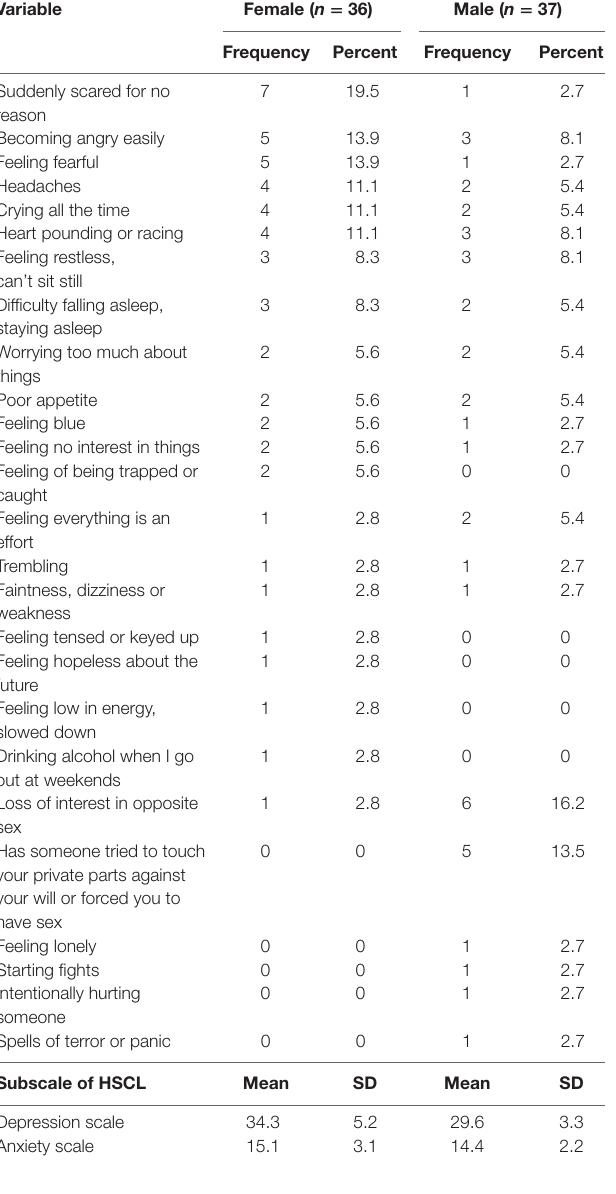
TaBle 3 | Frequency of psychological distress among children/adolescent iDPs by gender – Kaduna, nigeria.